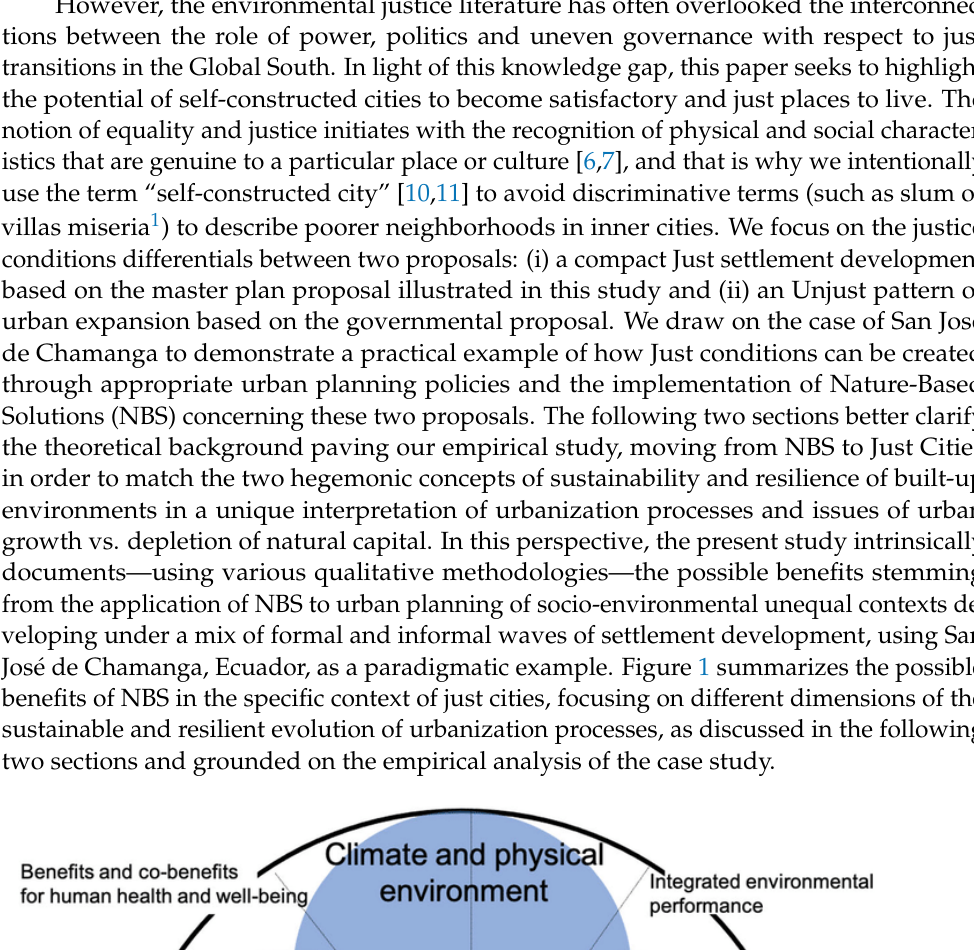
Table 1. This is a table caption. Tables should be placed in the main text near to the first time they are cited.